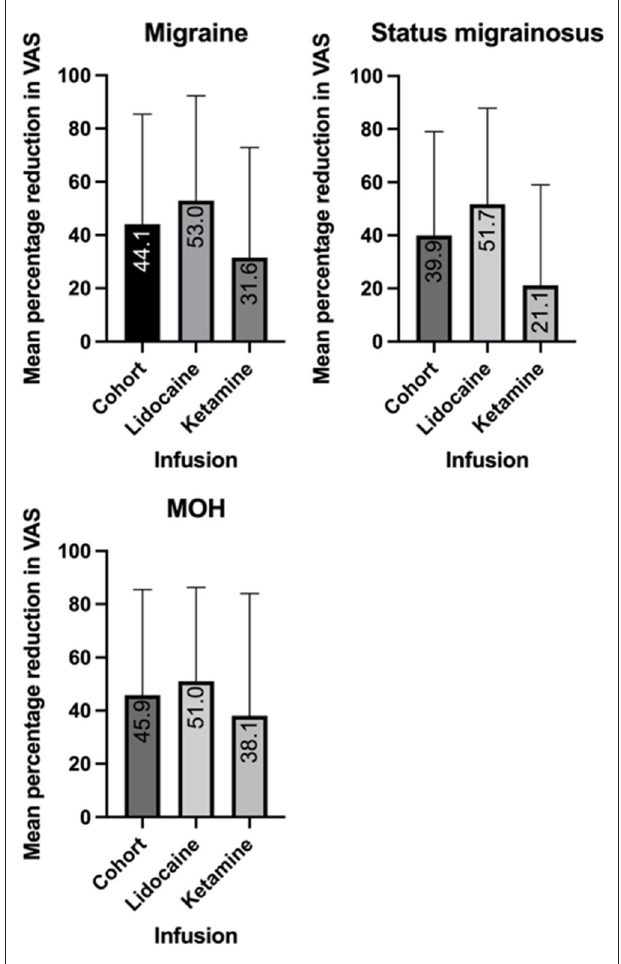
FIGURE 1 | Mean reduction in visual analog scale (VAS) score with intravenous lidocaine and ketamine in migraine, medication overuse headache (MOH) and status